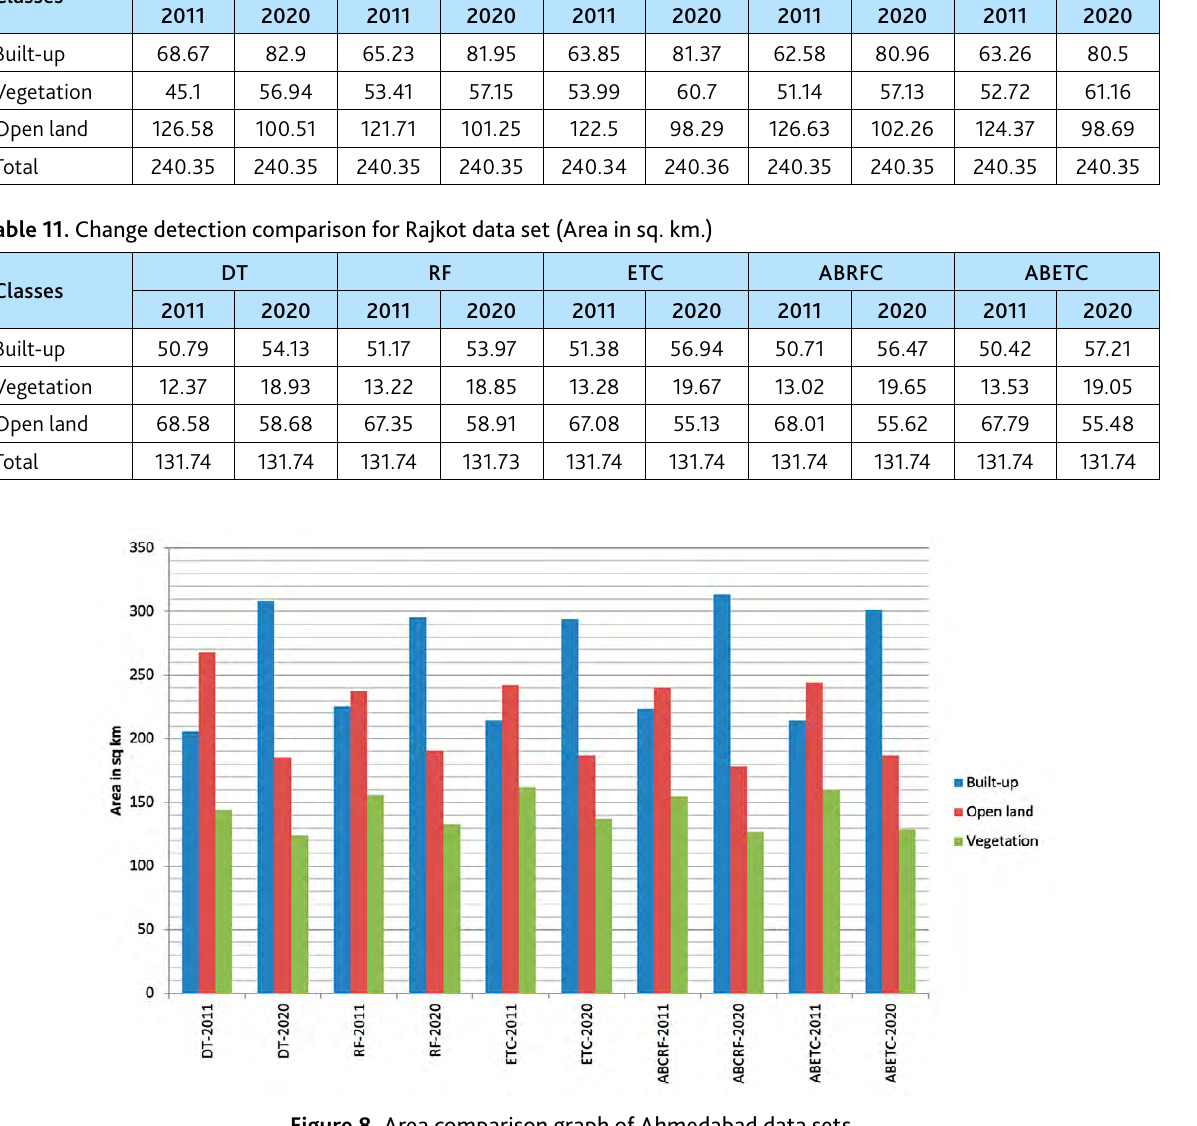
Table 10. Change detection comparison for Vadodara data set (Area in sq. km.) Classes